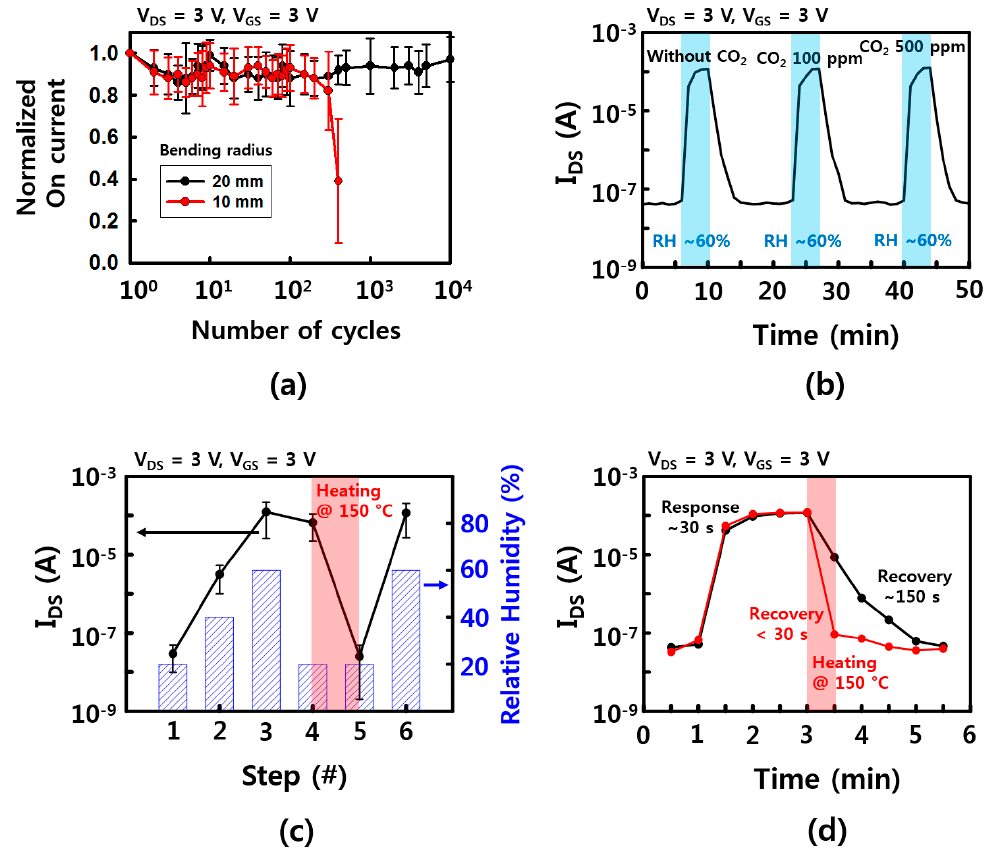
Figure 6. Device stability characteristics. ( a ) Mechanical stability of the sensor device. Normalized on current as a function of bending cycles with bending radius of 10, 20 mm; ( b ) Response and recovery time with / without CO 2 gas (100 and 500 ppm); ( c ) the on current of the sensor devices depends on the condition of RH and the heating step for removal of water molecules; ( d ) response and recovery time with/without heating step. The error bars in ( a , b ) represent a 95% confidence interval.